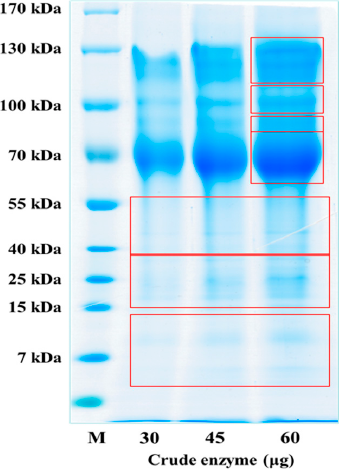
Figure 7. Separation of co-enzyme using SDS-PAGE.